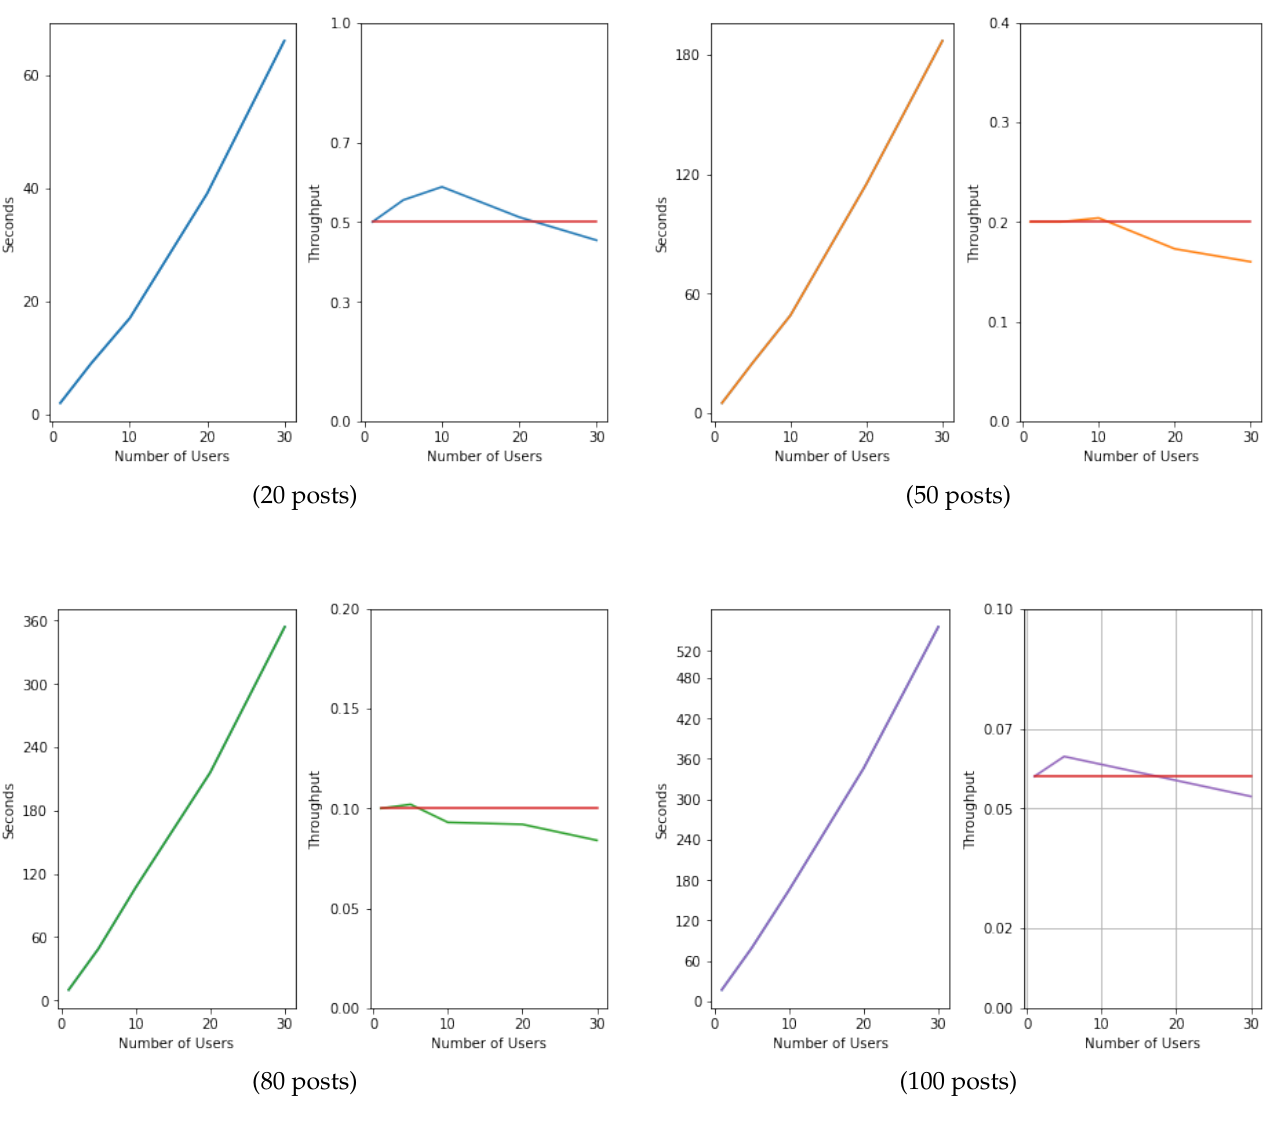
Figure 17. Reasoning response time and